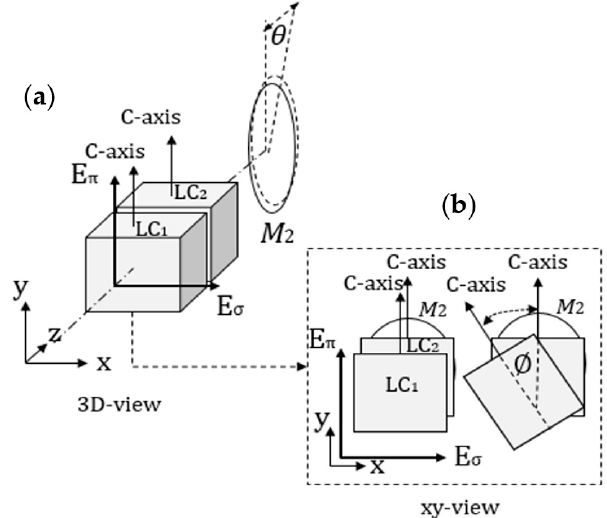
Figure 2. Configuration of 𝐿𝐶 (cid:2869) and 𝐿𝐶 (cid:2870) in multi wavelength emission. ( a ) A 3D configuration with a tilted angle of θ for 𝑀 (cid:2870) , and ( b ) xy-view of the setup for tri output wavelengths emission with θ =0.7 mrad and ∅ = 0 rad (left) and quad wavelengths emission (right) with θ =0.7 mrad and ∅ = 0.78